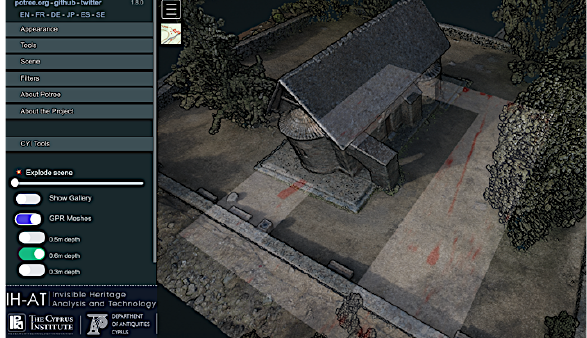
Figure 16. Panagia Phorviotissa (Asinou), Nikitari, 3D point cloud and GPR data (-0.6 m) displaying underground